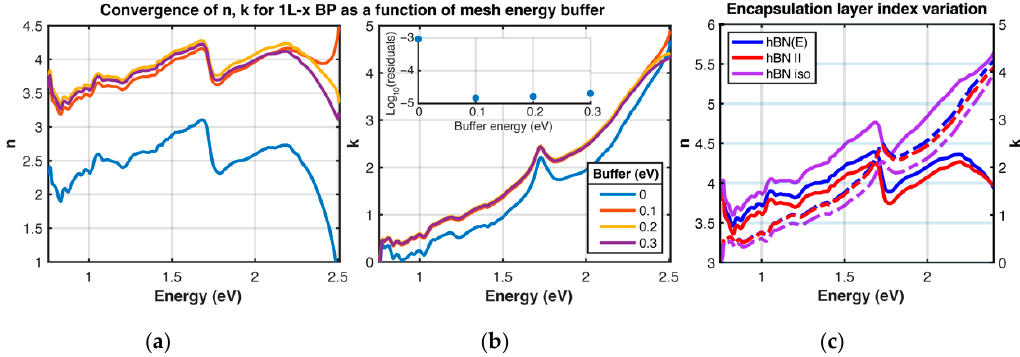
Figure 3. Systematic variation in CKKA + TMM parameters. Left ( a ) and center ( b ) plots: demonstration of convergence of CKKA + TMM fits for x-polarized excitation of 1L BP as a function of mesh energy bu ff er. This bu ff er is defined as the energy range extending beyond the experimental data acquisition range used in the CKKA + TMM fit. ( a ): real index of refraction n as a function of bu ff er energy in eV (see legend in plot on right). ( b ): extinction coe ffi cient k as a function of bu ff er energy. Inset of ( b ): log 10 of the residuals of the dR / R fits as a function of bu ff er energy. Residuals are defined here as (cid:12) (cid:80)(cid:12) 2 (cid:12) (cid:12) x fit , j − x data , j . ( c ): variation of the index of refraction for the 15 nm hexagonal boron nitride (hBN) encapsulating layer. hBN(E), hBN || and hBN iso correspond to using the Sellmeier equation form of the index of refraction for in-plane hBN, a constant value of 𝑛 (cid:3035)(cid:3003)(cid:3015) = 2.108 [33], and a constant value 𝑛 (cid:3035)(cid:3003)(cid:3015) = 1.86 [34], respectively. Solid lines correspond to n of BP, and dashed lines correspond to k of BP, as indicated by solid and dashed arrows.